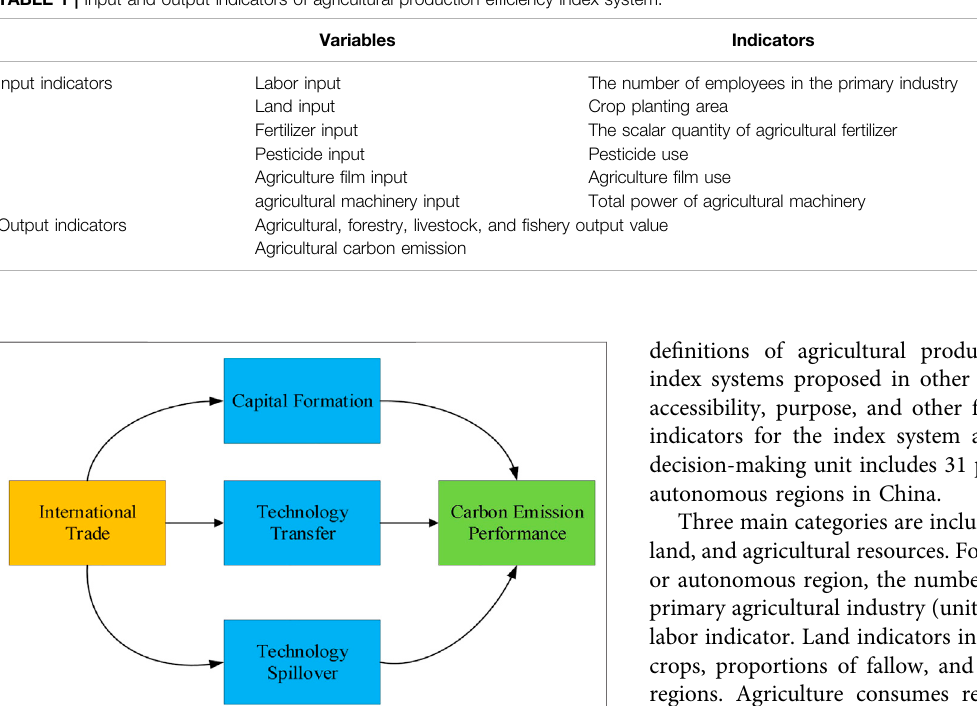
TABLE 1 | Input and output indicators of agricultural production ef fi ciency index system.